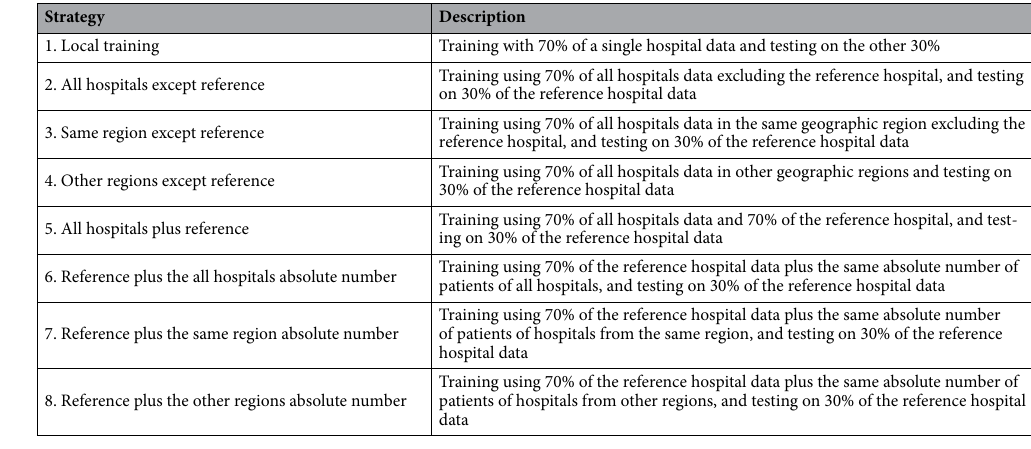
Table 3. Clustering strategies for training and